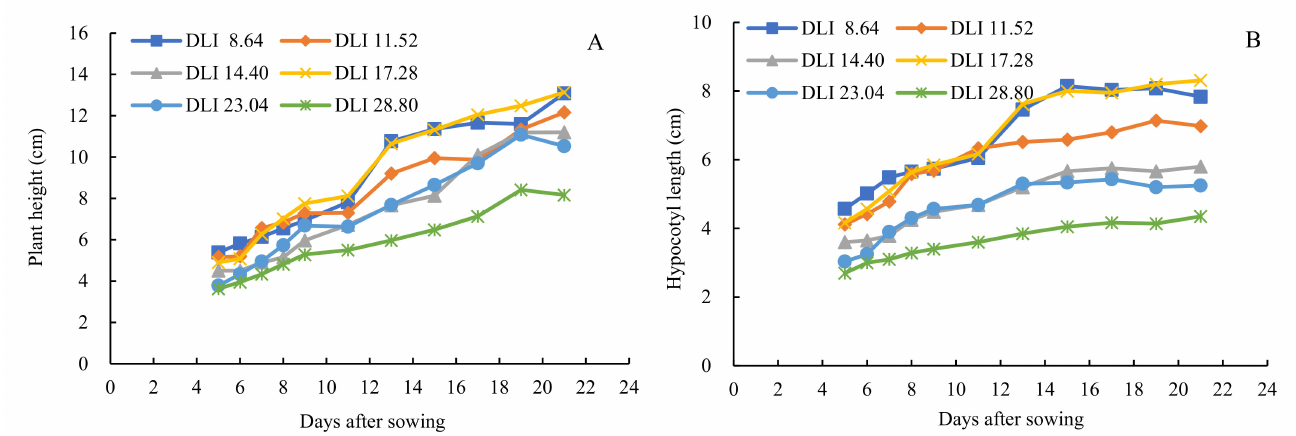
Figure 2. Time course of ( A ) plant height and ( B ) hypocotyl length of cucumber seedlings grown in a closed transplant production system as affected by daily light integral